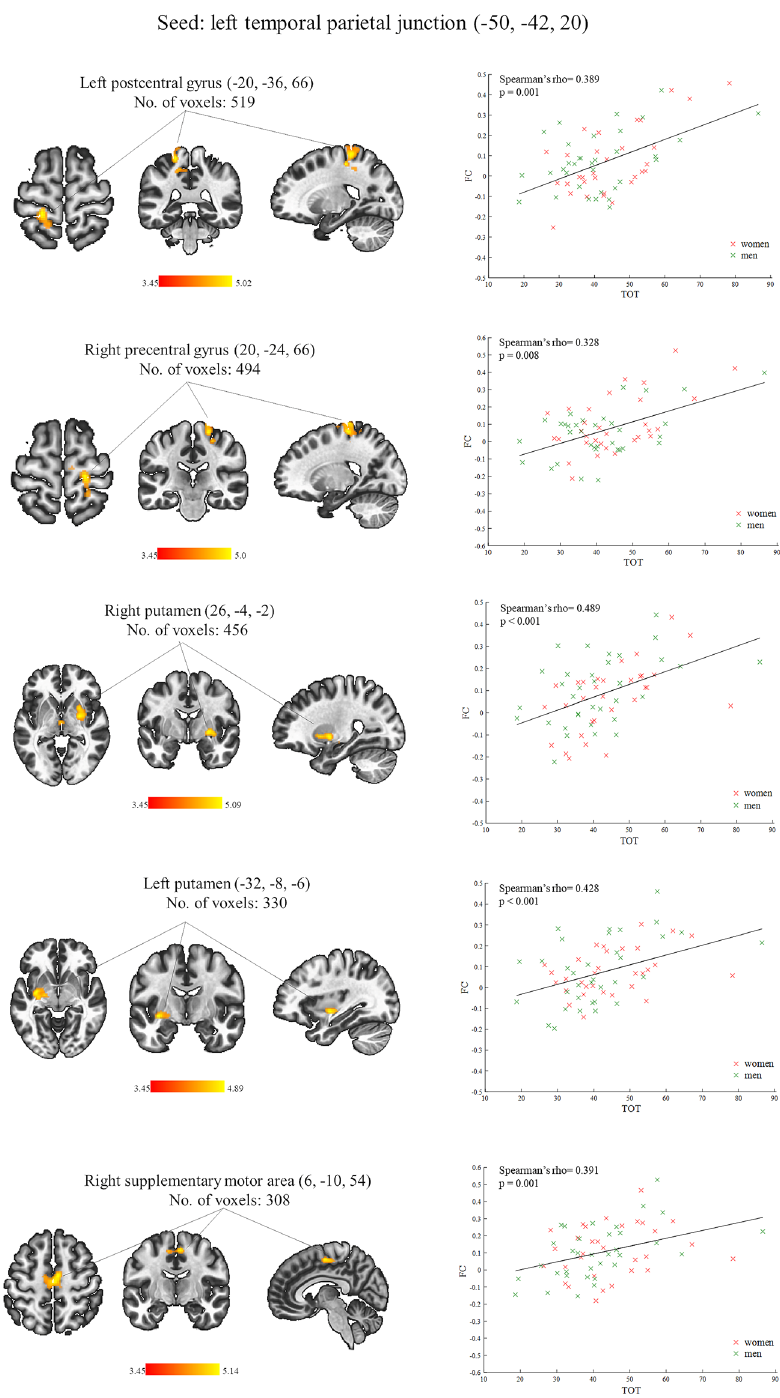
Figure 2. (Left) Brain regions demonstrating a significant positive association between the temporal order threshold (TOT) values and functional connectivity (FC) values seeded from the left temporal parietal junction while the gender effect was controlled. The Montreal Neurological Institute (MNI) coordinates of center position of the seed area are put right after the name of it, in the bracket. The size of the whole target region is given in the number of voxels (each voxel size: 2 × 2 × 2 mm), and the name indicates the anatomical area the majority of the voxels belonged to. The color bars represent T scores. (Right) Scatter plots of functional connectivity (FC) parameters as a function of the temporal order threshold (TOT) at the peak voxel of each target region. The FC values for women are marked in red and for men in green. The black solid line represents a best fit for linear regression on a datasets with outliers (fit robust linear regression). The values of Spearman’s rho coefficients that measure the strength of association between the TOT and FC and their significance levels (p) are placed in the left upper corner of each scatter